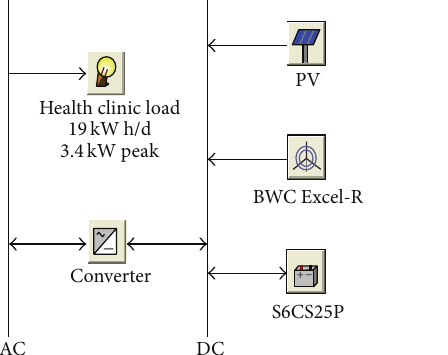
Figure 4: The network architecture for the HOMER simulator (pro- posed PV/wind power system).